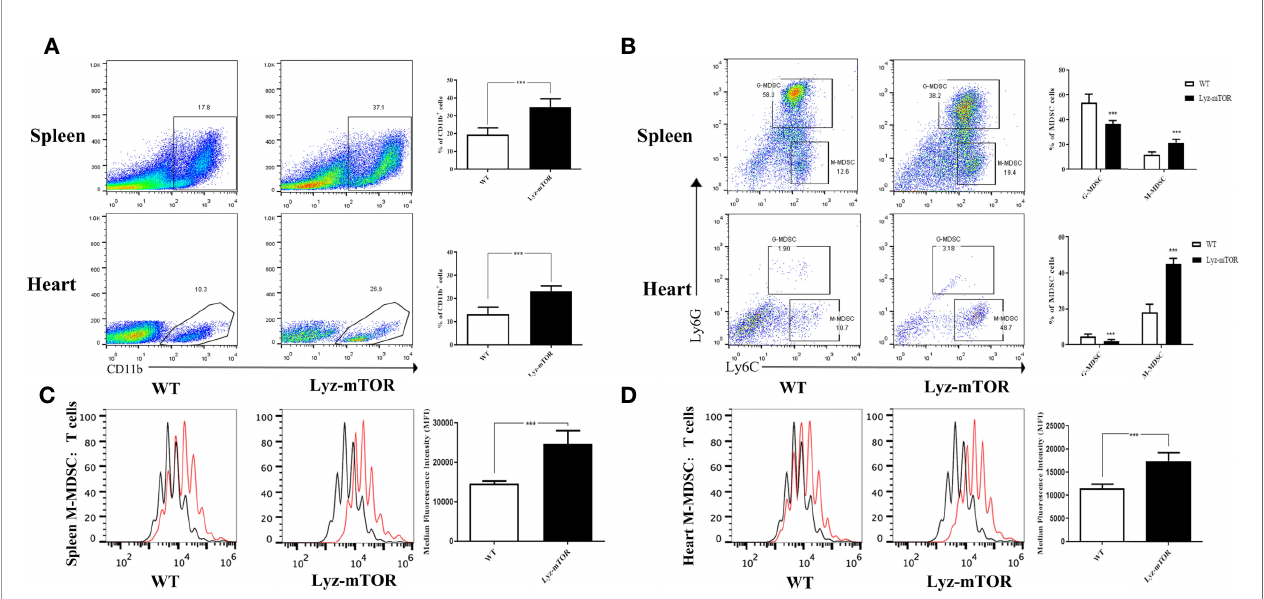
FIGURE 1 | Enhanced M-MDSC differentiation and immunosuppressive function in Lyz-mTOR mice. (A) Percentages of CD11b + cells in spleens and hearts from WT and Lyz-mTOR mice. (B) Percentages of G-MDSCs and M-MDSCs in spleens and hearts from WT and Lyz-mTOR mice. (C, D) CFSE-labeled T cell proliferation pattern